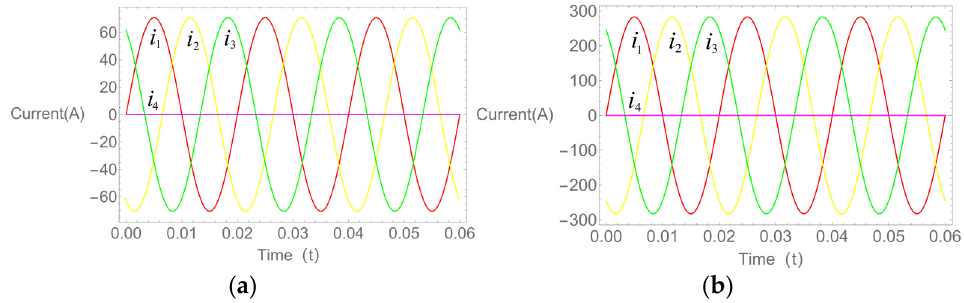
Figure 9. Schematic diagram of 25 mm 2 reduction current. ( a ) Reduction current at 50 A; ( b ) Reduc- tion current at 150 A.